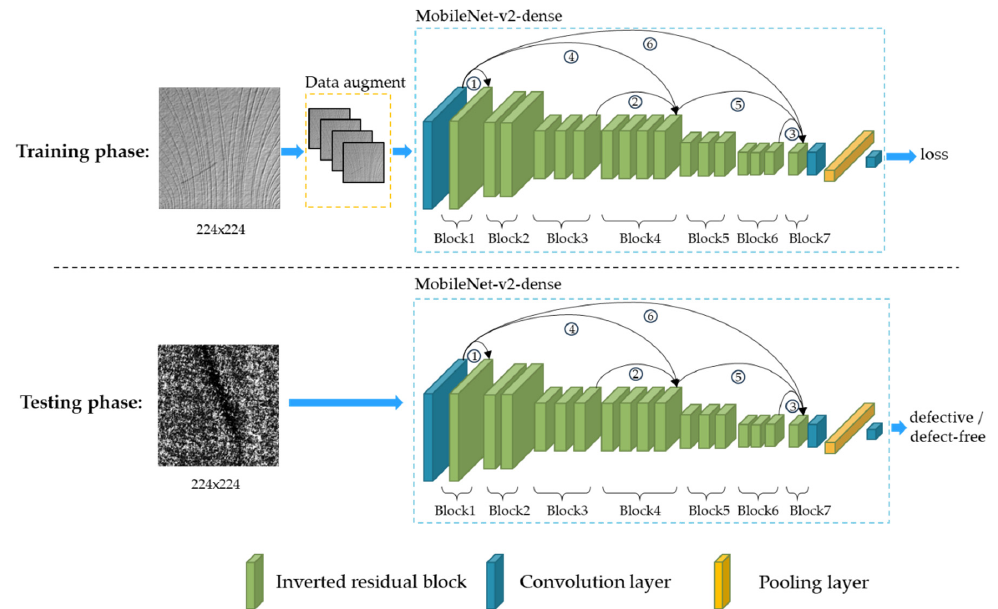
Figure 1. The structure of the MobileNet-v2-dense network. Where the block names correspond to Table 1. Solid lines in a diagram are concatenation from a shallow feature map to the deep one. The main component of the network is composed of multiple cascaded inverted residual blocks with downsampling. The structure of the inverted residual block is shown in Figure 2. The inverted residual block takes a low-dimensional compressed representation as an input, which first expanded to high dimension and filtered with lightweight depthwise convolution. Features are subsequently projected back to a low-dimensional representation. The dense concatenation is used between inverted residual blocks to carry shallow features to deeper layers of the network, which is the fusion of multi-scale information. The network structure of MobileNet-v2-dense is formed by dense